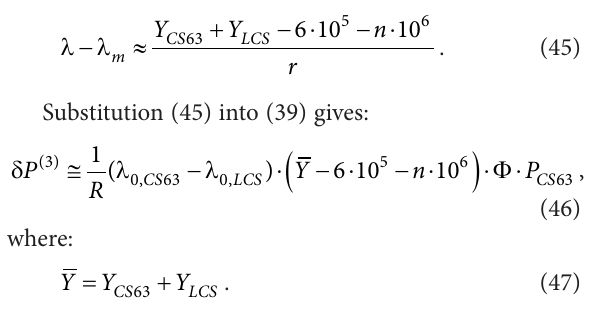
Figure 3. Graph of change δ (3) P depending on longitude along the parallel with latitude 48.5 ϕ = ° for a parcel of 1 hectare in the transition from CS-63 to